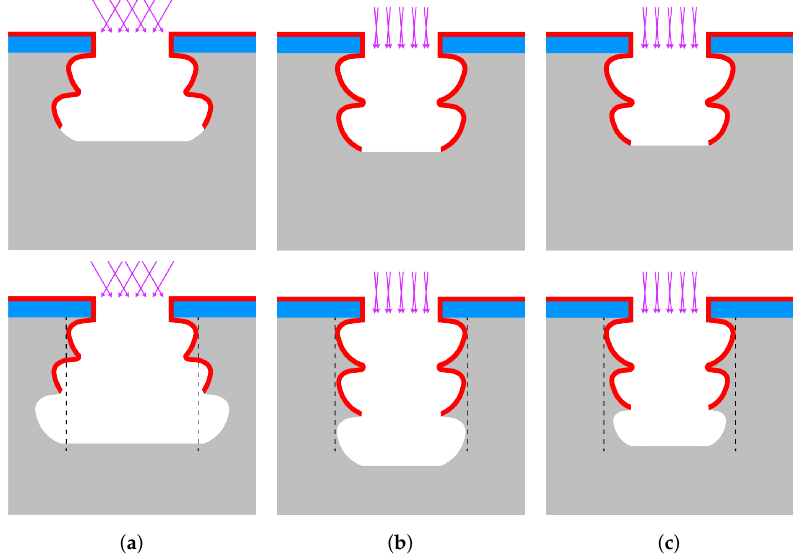
Figure 5. HAR profile control by scallop dimension and position tailoring by utilising the etch-cycle time and pressure (IAD). In ( a ), a negative trench profile is created by using a large IAD (etch pressure > 30mTorr) and constant etch-cycle time. In ( b ), a directional trench profile is created by using a small IAD (etch pressure < 10mTorr) and constant etch-cycle time [28,29]. In ( c ), a positive trench profile is created by using relatively short and constant (or ramped down) etch-cycle time and a small IAD. In this image, the colours correspond to the following materials: silicon, t-SiO 2 hard mask, and FC passivation layer. The purple colour in the second row indicates the IAD in the plasma. The concentration of ions is the highest in the centre (near perpendicular to the surface).